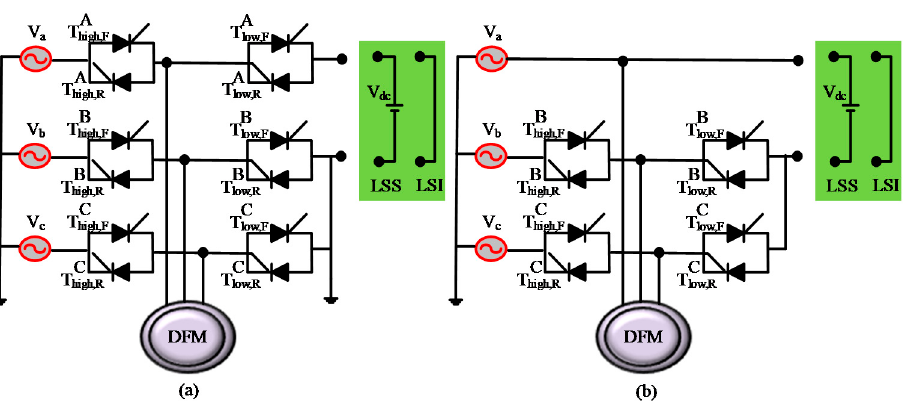
Figure 8. SCR-based transfer switch topologies. ( a ) TTB—the neutral of the ac source voltage is the reference for the transfer switch operation; ( b ) ETB—A phase of the ac source is the reference for the transfer switch operation [41].